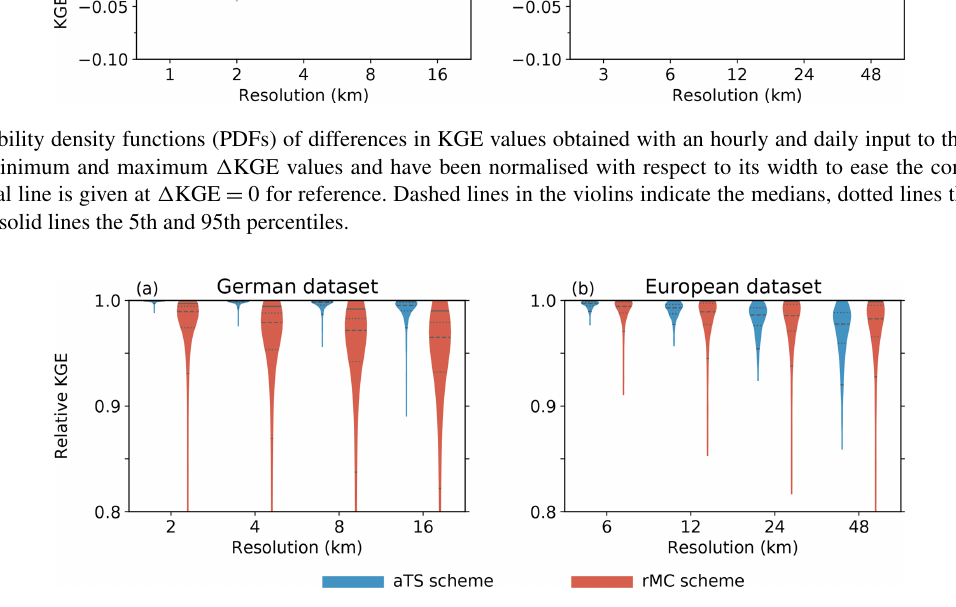
Figure 5. Probability density functions (PDFs) of relative KGE values for the adaptive time step scheme (aTS, blue violins) and the region- alised Muskingum–Cunge (rMC) routing scheme (red violins). KGE values are calculated relative to the finest possible spatial resolution, which is 1km for the German (a) and 3km for the European dataset (b) . PDFs are limited to the minimum and maximum relative KGE values and are scaled to the same widths. Dashed lines in the violins indicate the medians, dotted lines the 25th and 75th percentiles, and solid lines the 5th and 95th